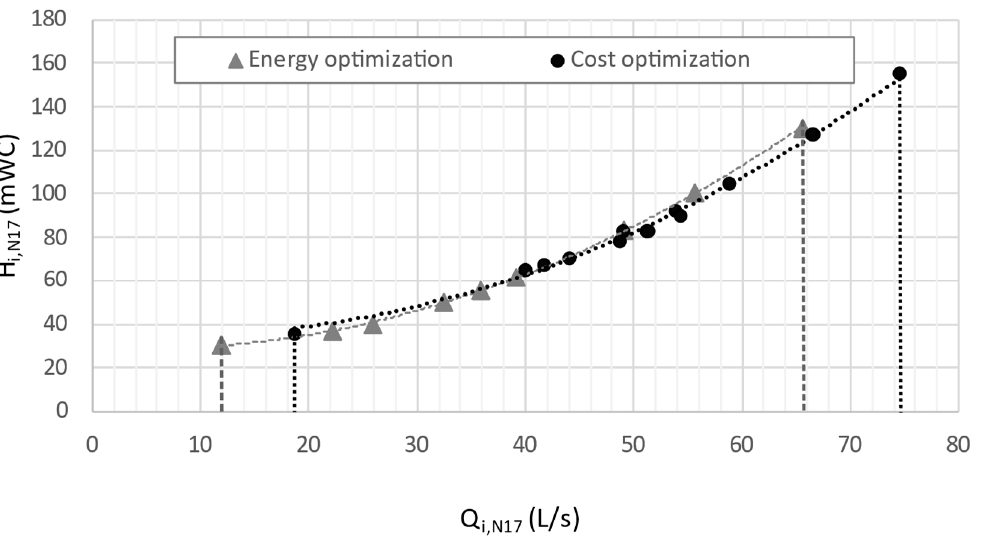
Figure 5. Setpoint curve for pumping station N17.